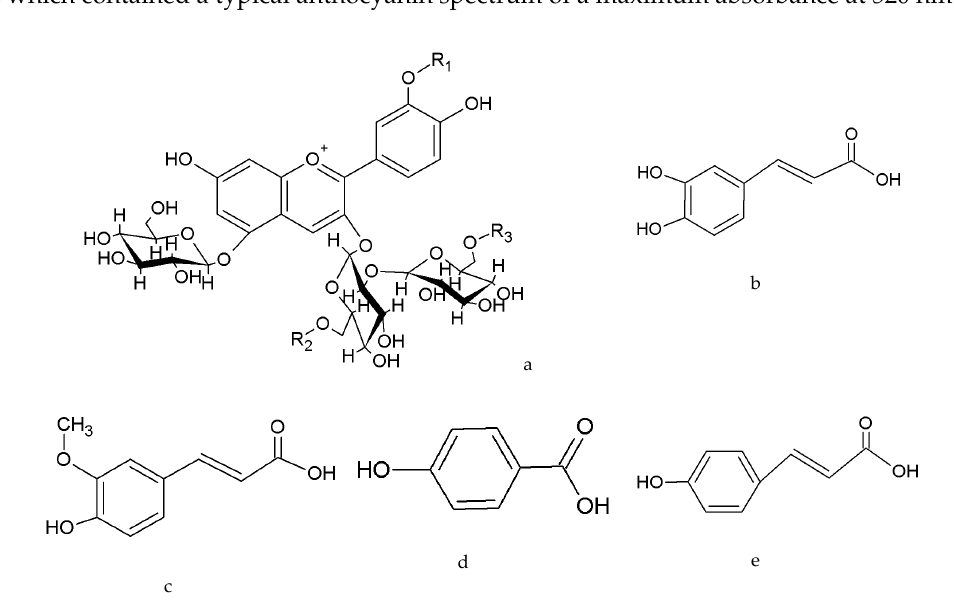
Figure 2. Skeleton structures of anthocyanins in sweet potato leaves. ( a ) Skeleton structures of anthocyanins; ( b ) caffeic acid ( m / z 180); ( c ) ferulic acid ( m / z 194); ( d ) p -hydro benzoic acid ( m / z 138); and ( e ) p -coumaroyl acid ( m / z 164).